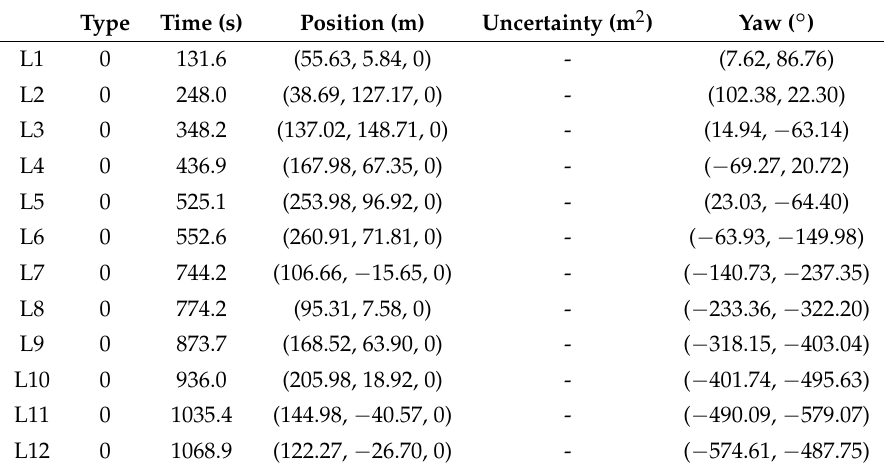
Table 3. Data Base Generated for the Drifted Trajectory Depicted in Figure